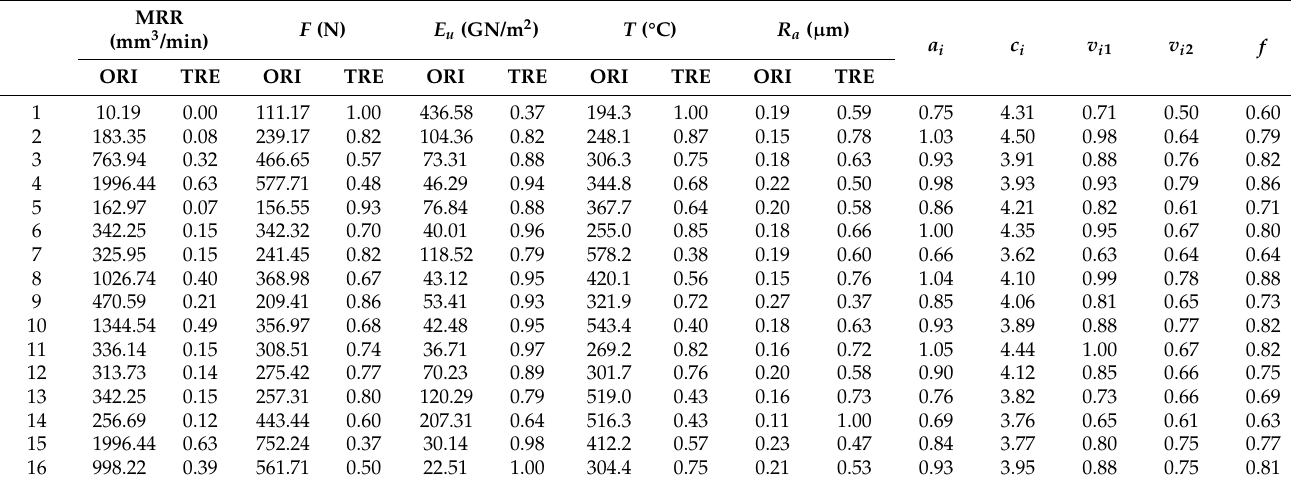
Table 6. Machinability evaluation indexes (original value and treated results by normalization and standardization) and the comprehensive evaluation